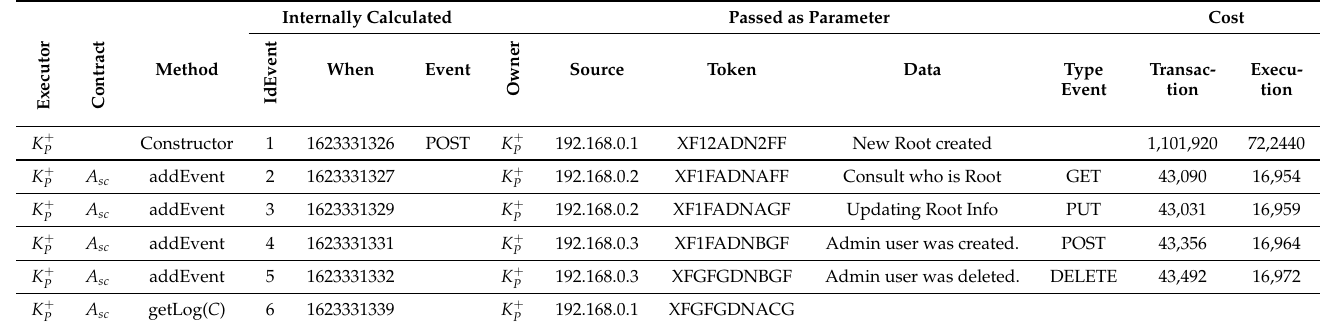
Table 3. Cost of the transactions of the events generated in Figure 6.